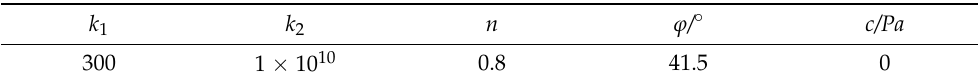
Table 2. Parameters of the